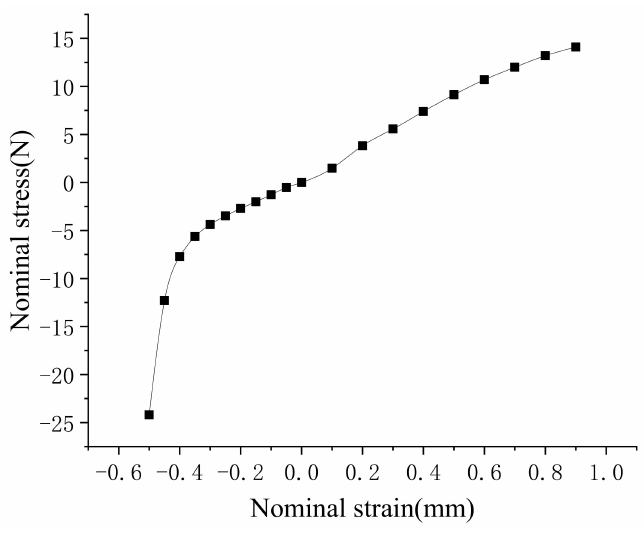
Figure 4. Stress–strain